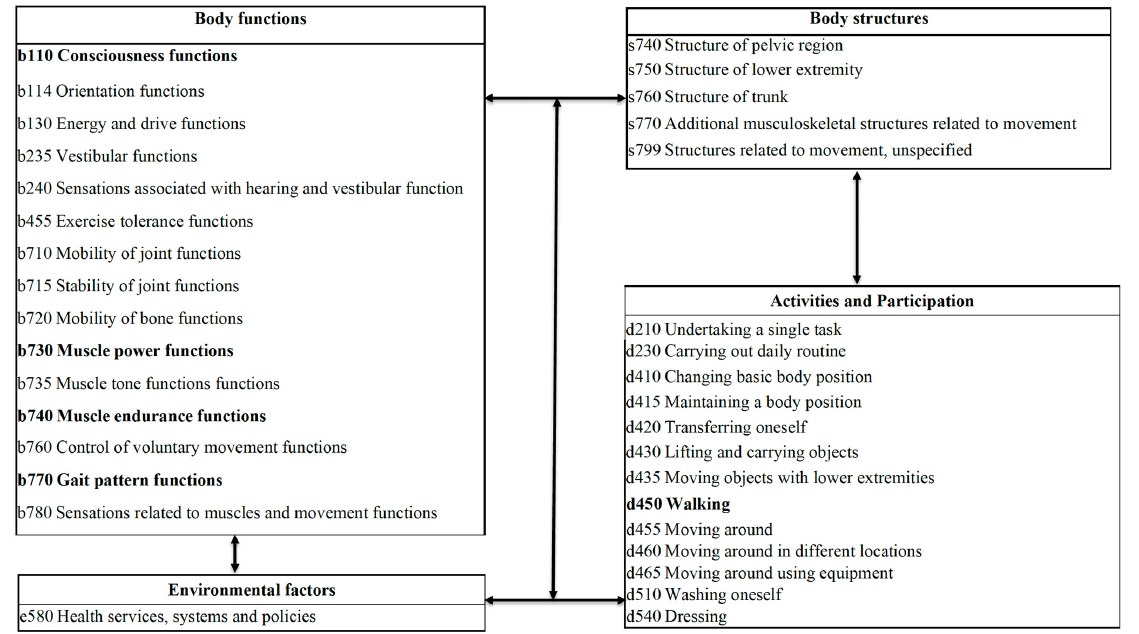
Figure 2. ICF core set of factors associated with post-hip-fracture rehabilitation. The arrows present the association of different categories based on ICF framework. the association of different categories based on ICF